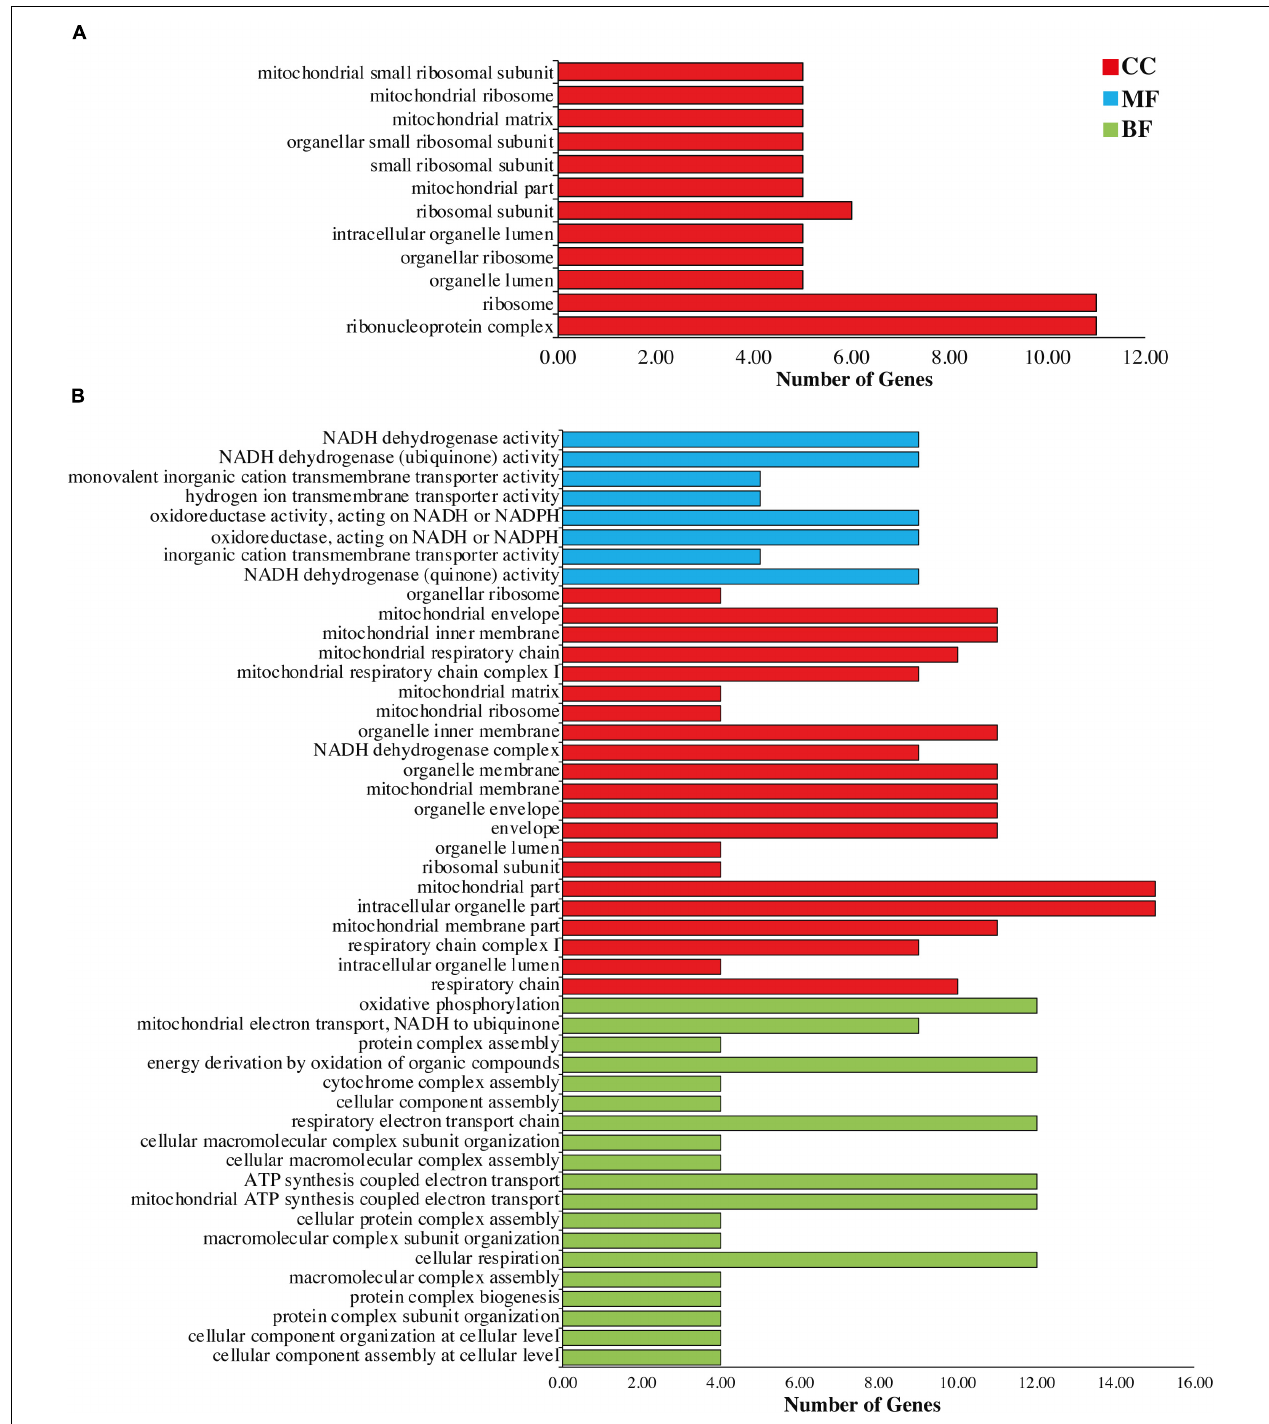
FIGURE 3 | Gene Ontology annotation of genes of (A) chloroplast and (B) mitochondria. Red color showing cellular components (CC), blue color representing molecular functions (MF), and green color showing biological functions (BF).